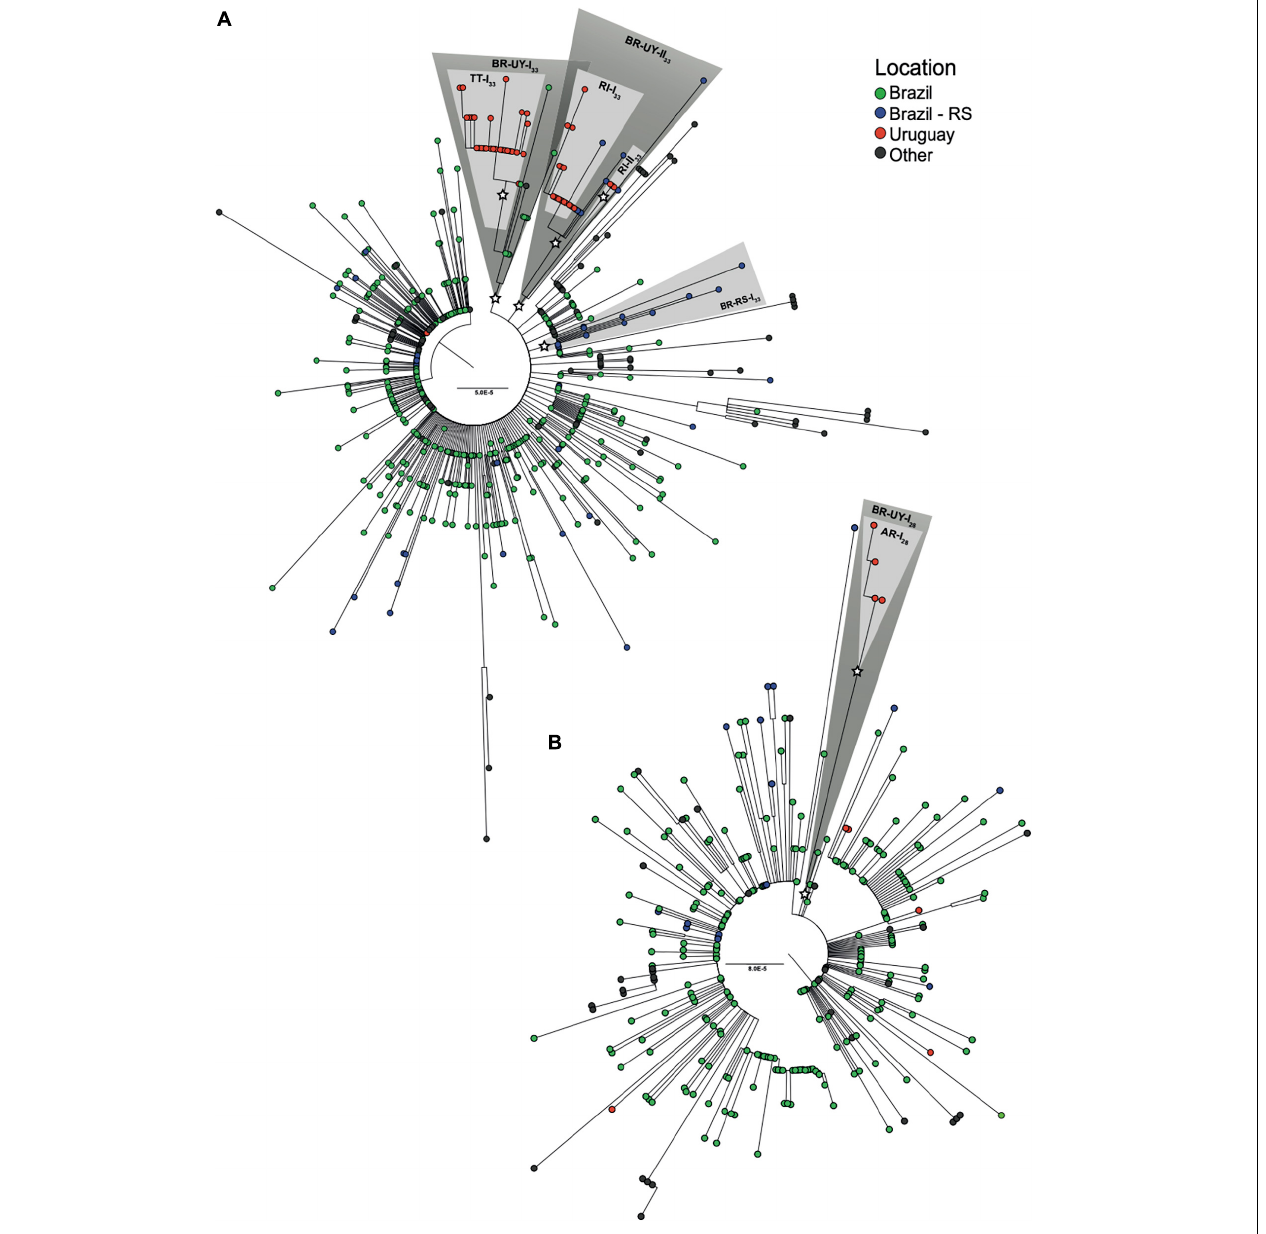
FIGURE 2 | Identification of major SARS-CoV-2 Uruguayan–Brazilian clades. ML phylogenetic trees of (A) 86 B.1.1.33 and (B) 23 B.1.1.28 genomes obtained in this study along with 492 and 275 worldwide reference sequences of the respective genotypes available in GISAID database. Tip circles are colored according to the sampling location. Node support (aLRT) values at key nodes are represented by asterisks (*). Shaded boxes highlight the position of clusters BR-UY-I 33 , BR-UY-II 33 , BR-RS-I 33 , BR-UY-I 28 , TT-I 33 , RI-I 33 , RI-II 33 , and AR-I 28 . The tree was rooted on midpoint and branch lengths are drawn to scale with the bars at the center indicating nucleotide substitutions per site. UY-AR, Artigas-Uruguay; UY-RI, Rivera-Uruguay; UY-TT, Treinta y Tres-Uruguay; BR-SE, Southeast Brazilian region; BR-RS, Rio Grande do Sul-